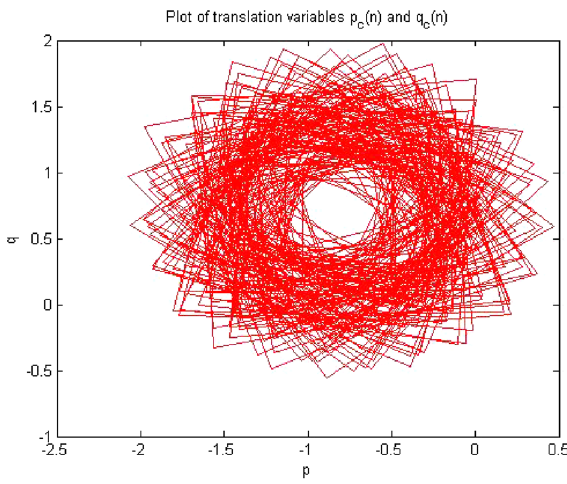
Figure 13. Plot of p vs q shows periodic behavior as it has bounded